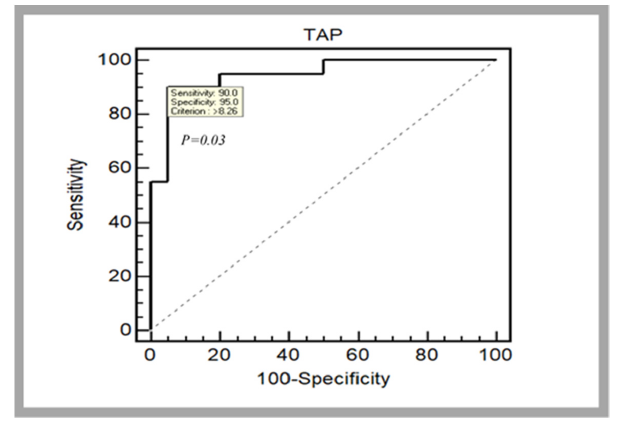
Figure 4. Receiver operating characteristics (ROC) curve for the TAP test between national and regional group level indicating that an equal or higher TAP score than 8.26 tap·s − 1 is considered a high TAP score performance.